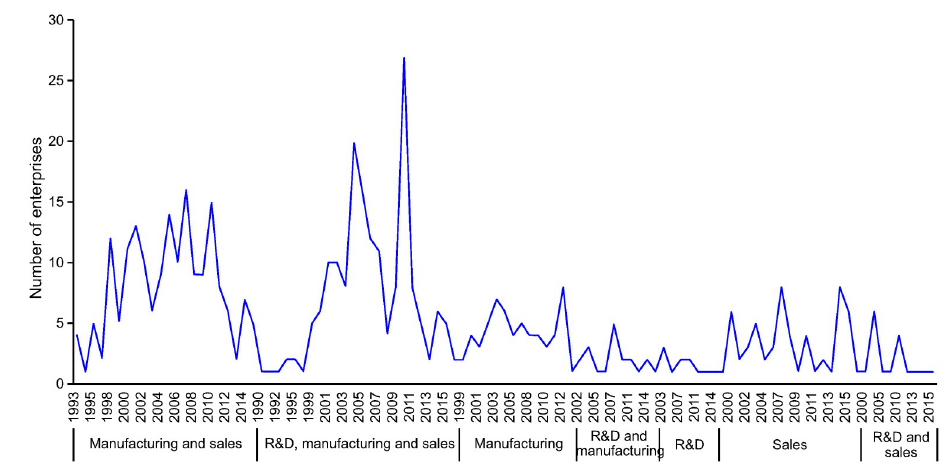
Fig 5. Temporal distribution of various value chain organization models of Taiwanese-listed OTC electronic information enterprises in Mainland China (annual increase in the number of enterprises).